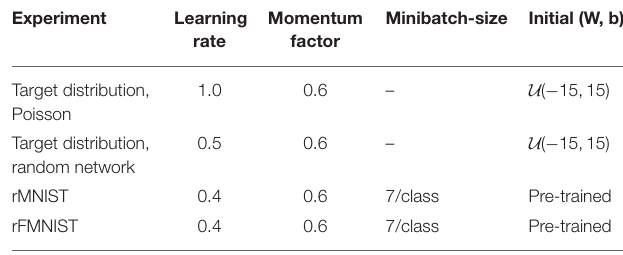
TABLE 3 | Network parameters. TABLE 4 | Parameters for